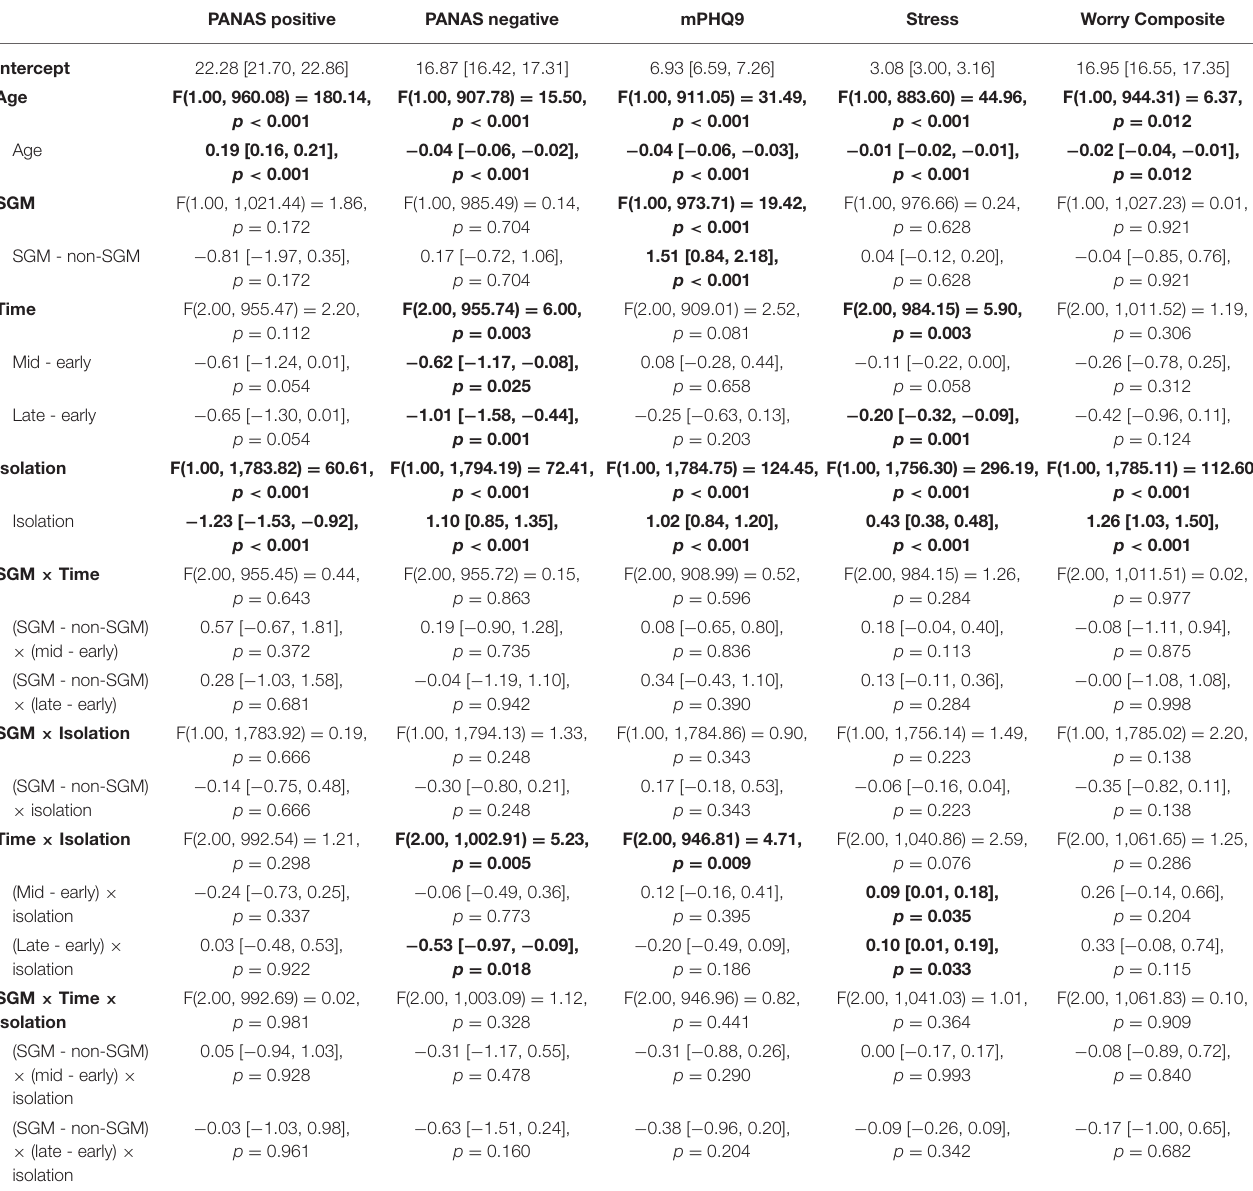
TABLE 3 | Model 2 regression